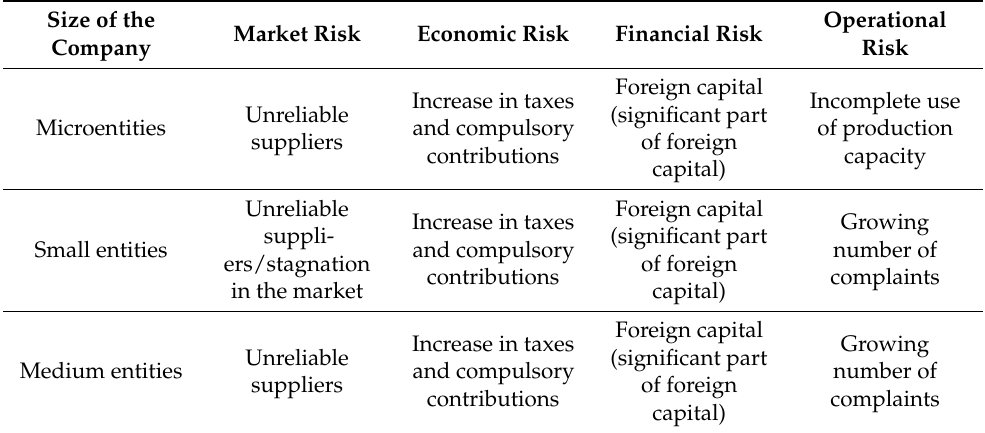
Table 9. Lowest risk factors broken down by the size of the company and percentage of extreme ratings during the COVID-19